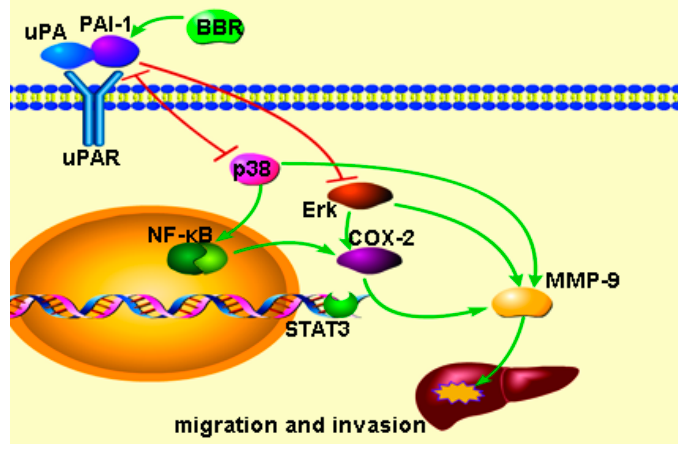
Figure 8. Schematic diagram of BBR-induced PAI-1 cell signaling pathway in HCC cells.